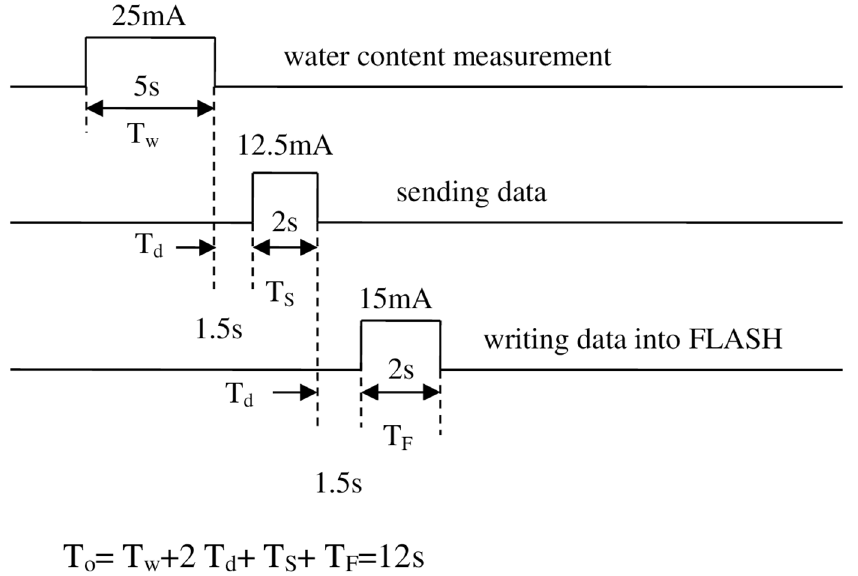
Fig 2. Layout executing sequence of a sampling process in the sensor system. To = overall operating time, Tw = time to measuresoil water content, T d = delay time in between,Ts = time to send data, T F = time to write data into